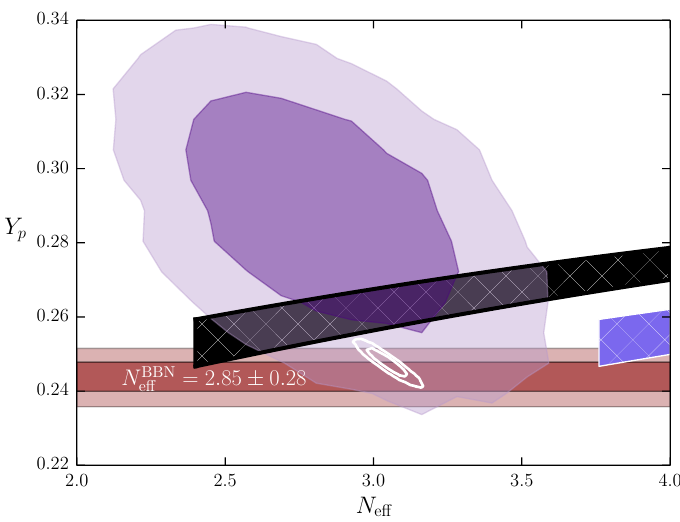
Figure 1 . Predictions for N e(cid:11) - Y p for thermal equilibrium with photons (black) and neutrinos (blue) assuming g DM = 1 and m dm < 1 MeV ((cid:12)xing ! b with a Planck prior). The length of the bands along the N e(cid:11) -axis allows for additional dark radiation to be added, which for photons can compensate the dilution of neutrinos from dark matter annihilation. The width of these bands along the Y p -axis allows for the dark matter to contribute (or not) to N e(cid:11) during BBN depending on its mass, with the largest value Y p corresponding to m dm 100 keV. Current Planck 1 and 2 (cid:27) contours are shown in (cid:28) indigo [18]. The red region shows the range of Y p that is predicted by BBN if we impose the current constraint N BBN = 2 : 85 0 : 28 [22] from the measurement primordial abundance, including D/H. e(cid:11) (cid:6) The direct measurement of primordial Y p -alone yields a weaker constraint of Y p = 0 : 2465 0 : 0097. (cid:6) In this way, we see that none of the hatched regions are consistent with all the information available from the CMB and abundance measurements. The white contours show forecasts for CMB Stage IV [20] (see also [21, 23]). We see that future CMB data could completely rule out the entire space without the need for abundance measurements. Figure adapted from